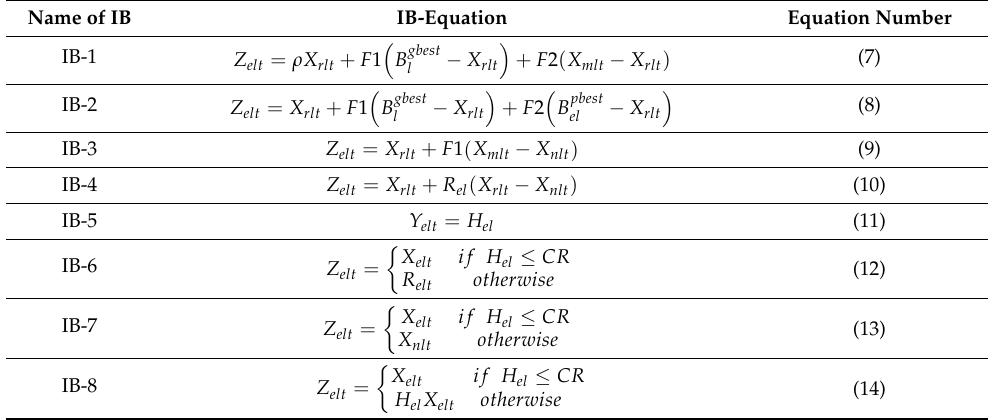
Table 14. IBs used in this